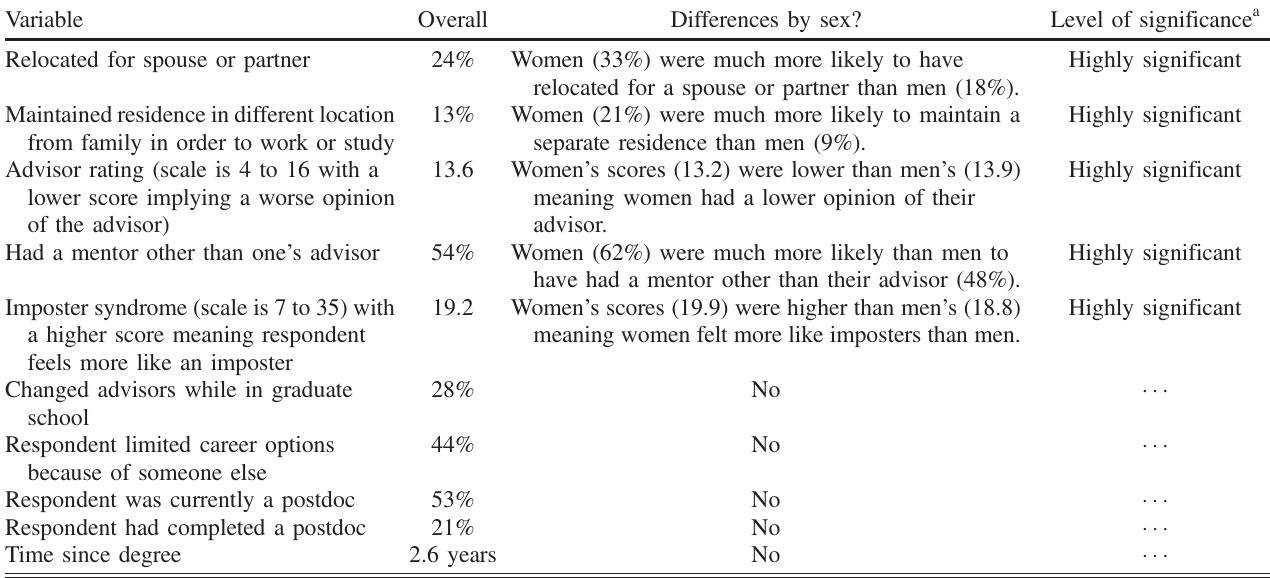
TABLE I. Characteristics of variables in the study that might affect